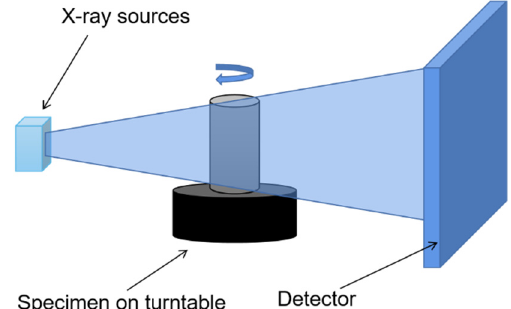
Figure 4. 225 KV industrial CT.